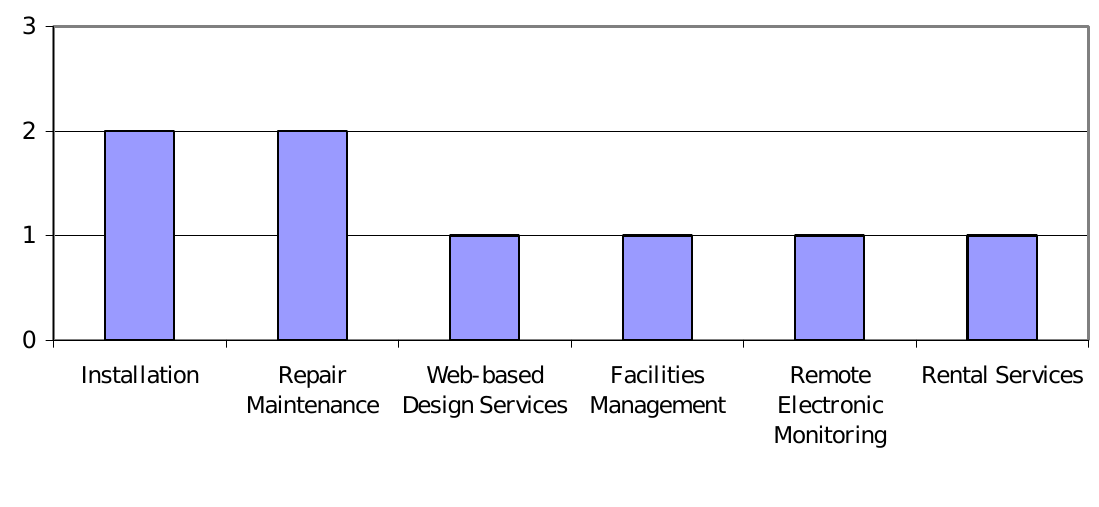
Figure 6: Fastest growing services offered, by number of